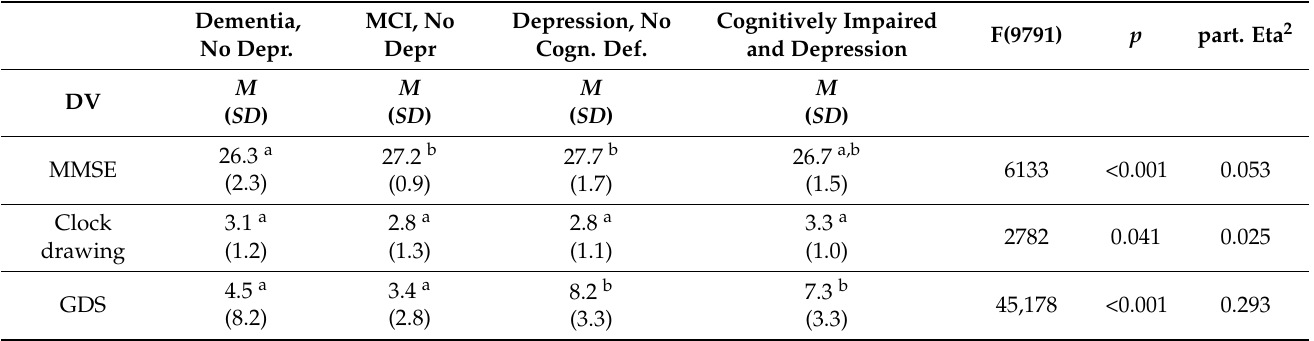
Table 3. Results of MANOVA with respect to screening procedures ( n =